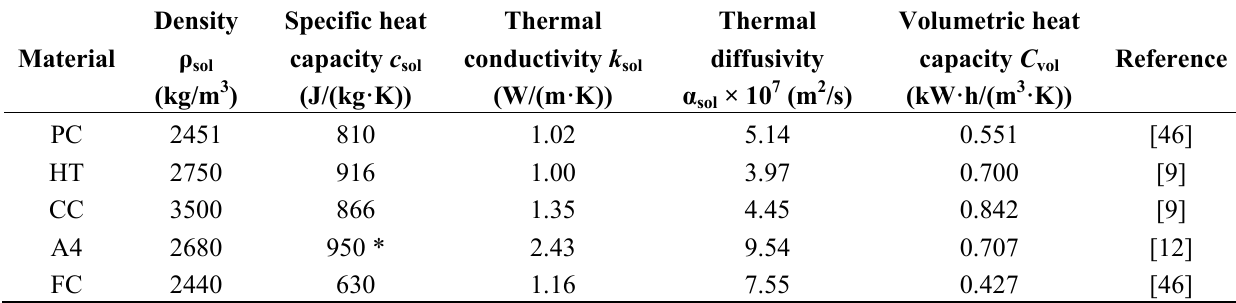
Table 1. Storage material selected in the literature for SHTES. PC: plain concrete; HT: high-temperature concrete; CC: castable ceramic; A4: graphite concrete; and FC: fiber-reinforced concrete.